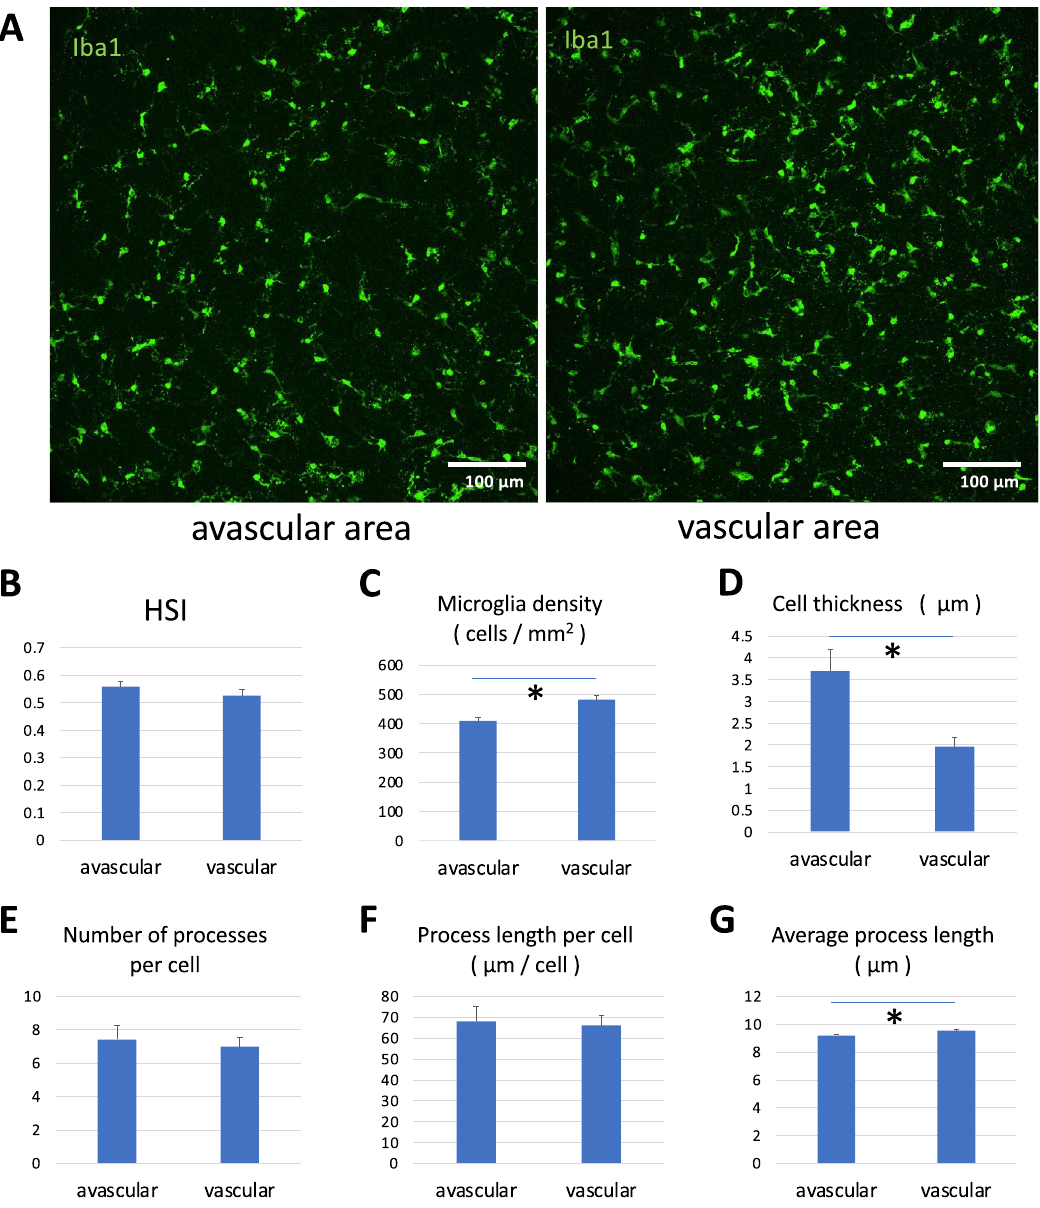
Figure 3. Quantification of Microglia distribution. ( A ) Microglia in the avascular and vascular area. ( B – G ) Quantification of the microglia distribution. ( B ) There was no significant difference in HSI. ( C ) Microglia density was higher in the vascular area. ( D ) Cell thickness was lower in the vascular area. ( E ) The number of processes per cell was not different. ( F ) Process length per cell was not different. ( G ) The average process length was longer in the vascular area. We used Student’s t -test ( ∗ p < 0.05 ) . All data are presented as mean ±